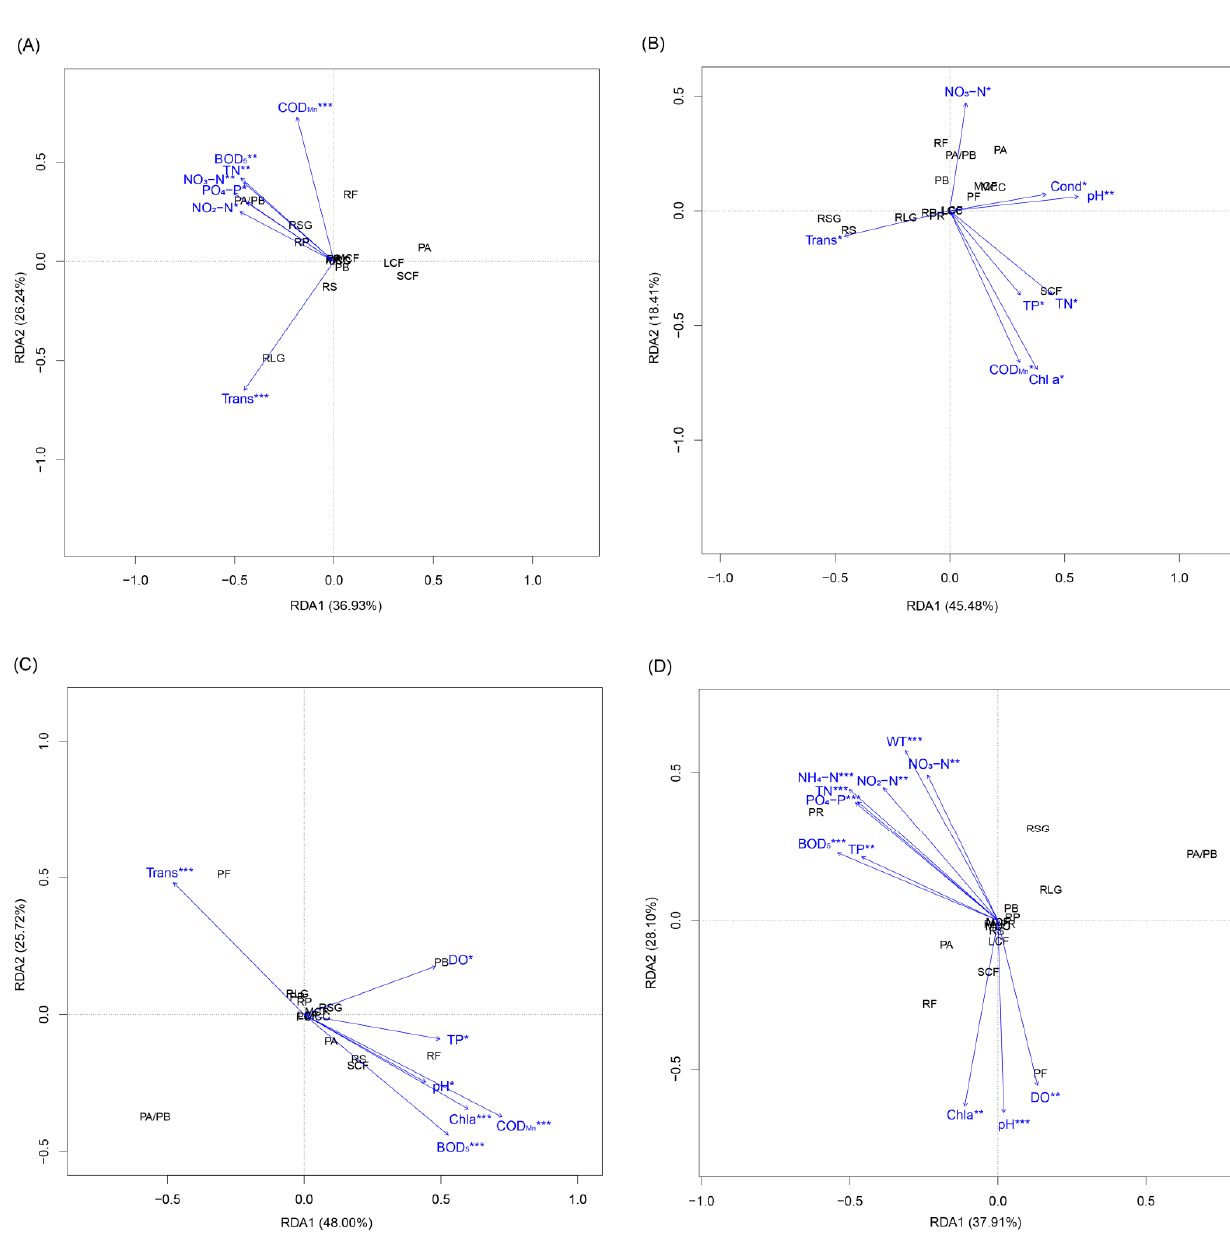
Figure 7. Redundancy analysis (RDA) for the zooplankton functional groups and environment factors. ( A ) spring, ( B ) summer, ( C ) autumn, and ( D ) winter. WT, water temperature; DO, dissolved oxygen; Cond, conductivity; Trans, transparency; TN, total nitrogen; TP, total phosphorus; COD Mn , permanganate index; BOD 5 , biochemical oxygen demand after five days; Chl a, chlorophyll-a. * p < 0.05; ** p < 0.01; *** p < 0.001.